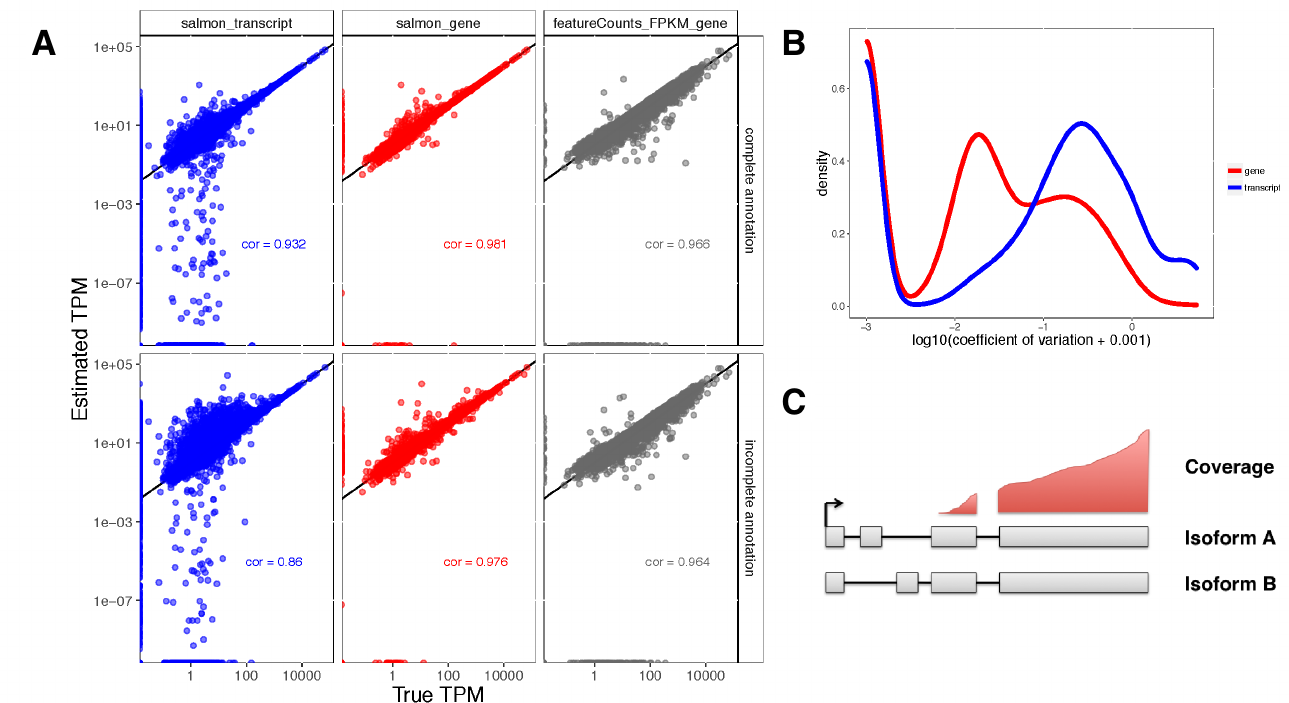
Figure 1 (sim2). A : Accuracy of gene- and transcript-level TPM estimates from Salmon and scaled FPKM estimates derived from simple counts from featureCounts , in one of the simulated samples (sampleA1). Spearman correlations are indicated in the respective panels. Top row: using the complete annotation. Bottom row: using an incomplete annotation, with 20% of the transcripts randomly removed. Gene- level estimates are more accurate than transcript-level estimates. Gene-level estimates from Salmon are more accurate than those from featureCounts . B : Distribution of the coefficients of variation of gene- and transcript-level abundance estimates from Salmon , calculated across 30 bootstrap samples of one of the simulated samples (sampleA1). Gene-level estimates are less variable than transcript-level estimates. C : An example of unidentifiable transcript-level estimates, as uneven coverage does not cover the critical regions that would determine the amount that each transcript is expressed, while gene-level estimation is still